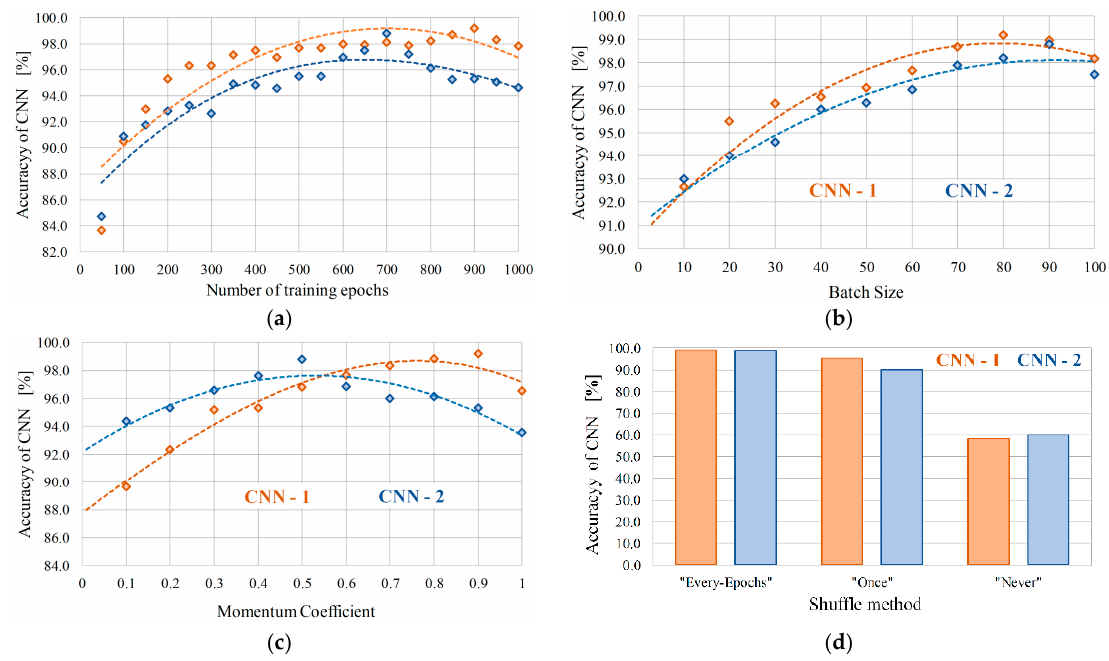
Figure 6. The impact of training parameters on the effectiveness of CNN structures: ( a ) the number of training periods; ( b ) data packet size; ( c ) momentum factor; ( d ) shuffling method.